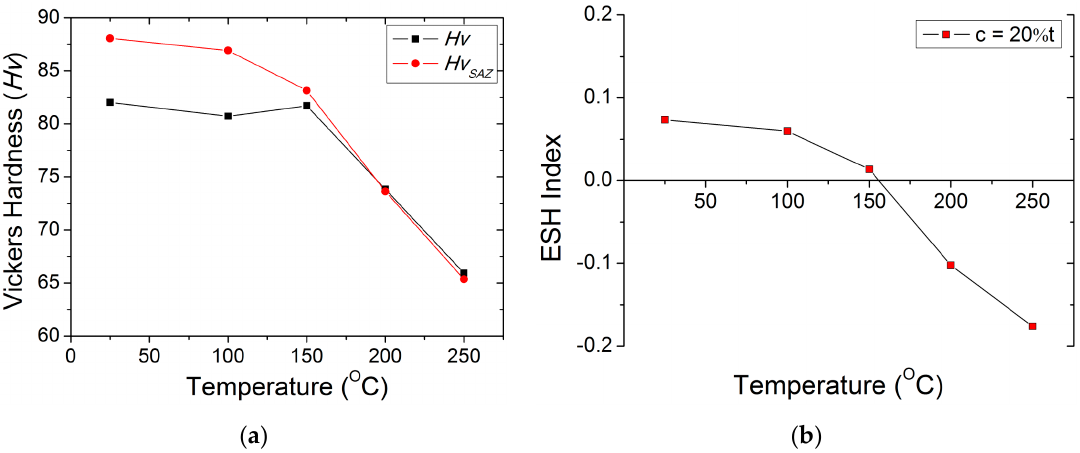
Figure 16. ( a ) Plot between Vickers hardness and heating temperature for the punch–die clearance of 20%; ( b ) plot between edge strain hardening (ESH) index and heating temperature for the punch–die clearance of 20%.